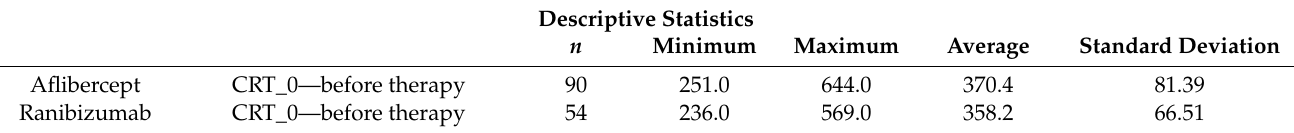
Table 4. Characteristics of study groups in terms of baseline central retina thickness